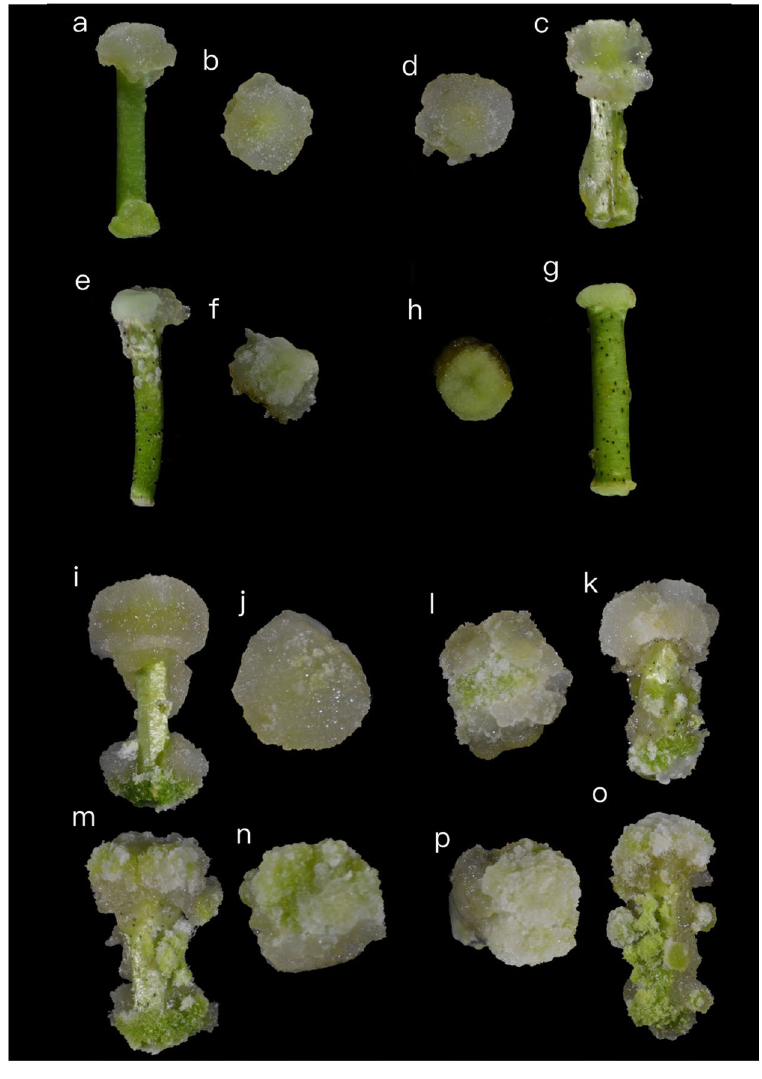
Figure 1. Four-cotton cultivars showing different differentiation at 10d and 1 month in the CIM. ( a–g ) after 10d of culture in CIM. ( i–o ) after 1M of culture in CIM. Four cotton cultivars of different induction stages were sampled, YZ1 ( a , b , i and j ), R15 ( c , d , k and l ), X33 ( e , f , m and n ) and X42 ( g , h , o and p